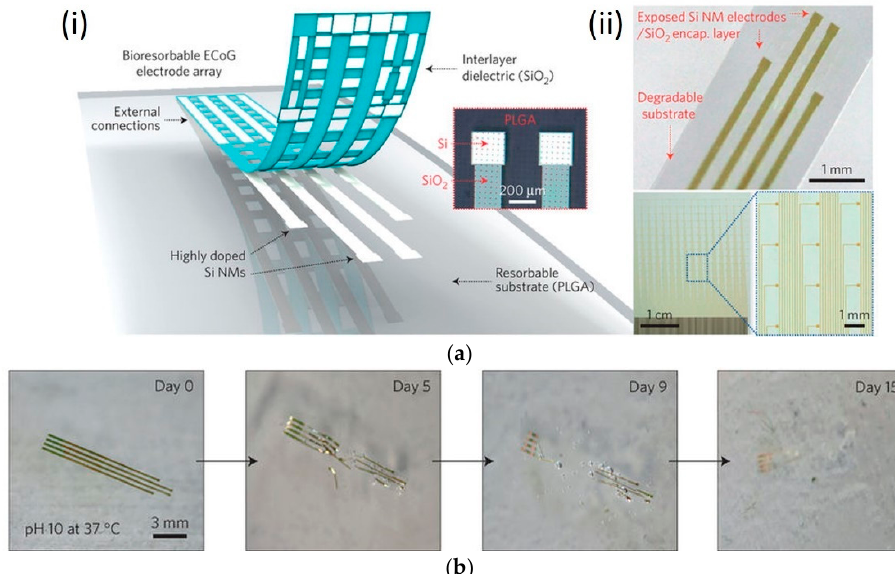
Figure 8. ( a ) (i) Schematic exploded-view illustration of the construction of a passive, bioresorbable neural electrode array for ECoG and subdermal EEG measurements; (ii) Photographs of bioresorbable neural electrode arrays with 4 channels (top) and 256 (16 × 16 configuration) channels (bottom); ( b ) Images collected at several stages of accelerated dissolution induced by immersion in an aqueous buffer solution (pH 10) at 37 °C. Reprinted by permission from Macmillan Publishers Ltd.: Nature Materials [116], copyright 2016.